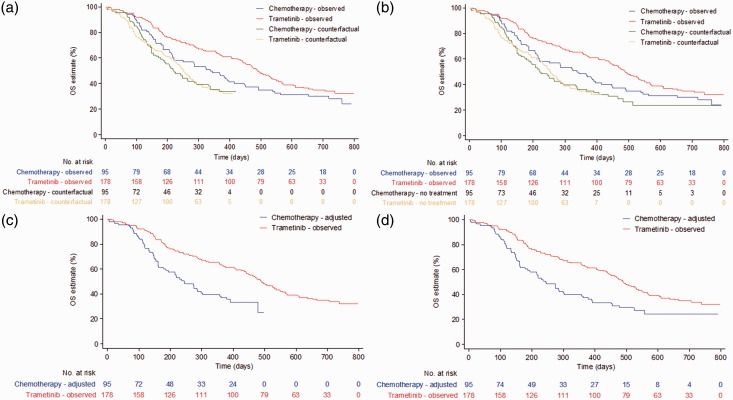
Trametinib compared to chemotherapy for metastatic melanoma: overall survival in primary efficacy population. (a) Rank-preserving structural failure time models (RPSFTM) with re-censoring; (b) RPSFTM without re-censoring; (c) two-stage method with re-censoring; (d) two-stage method without re-censoring. Adapted from Latimer et al.11